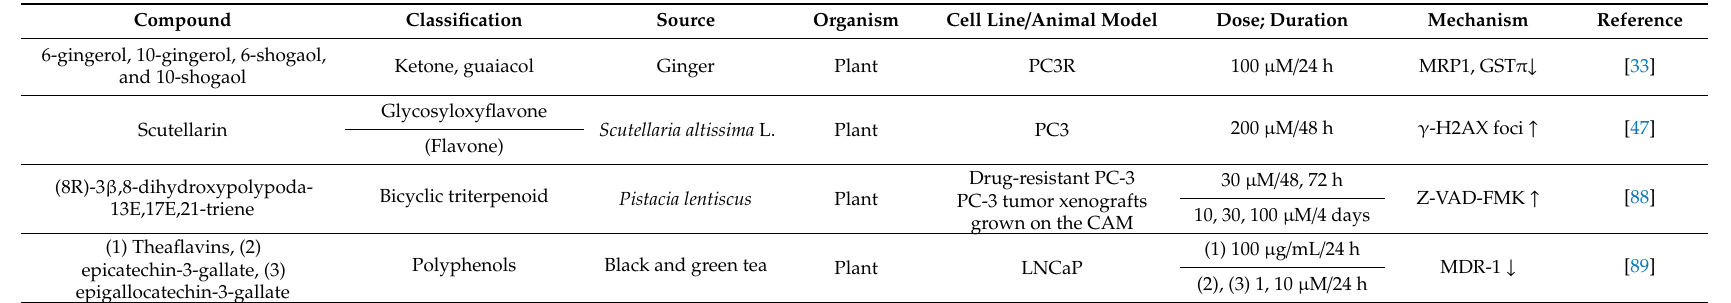
Table 8. Multi-drug resistance sensitizing dietary